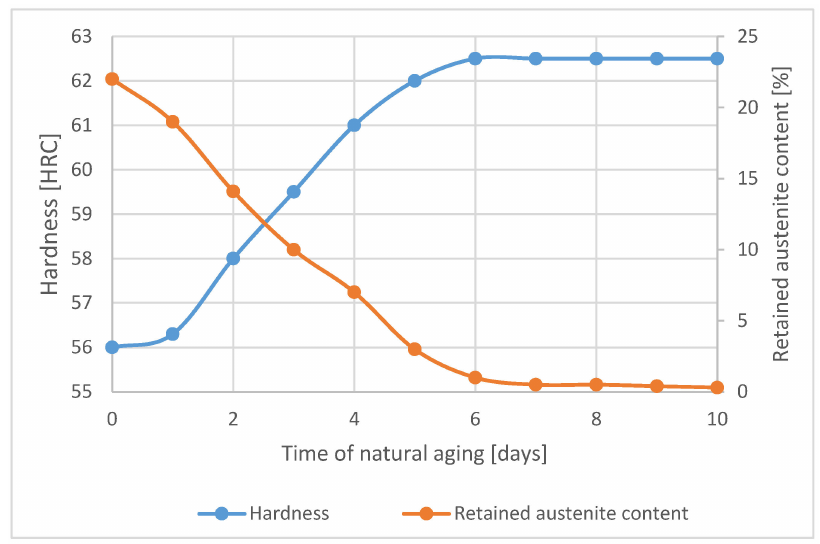
Figure 2. Hardness increase of experimental KAB steel A, during natural aging after quenching in oil from 900 ◦